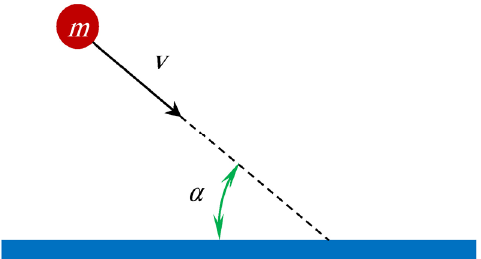
Fig. 1 Impact of a particle on a surface